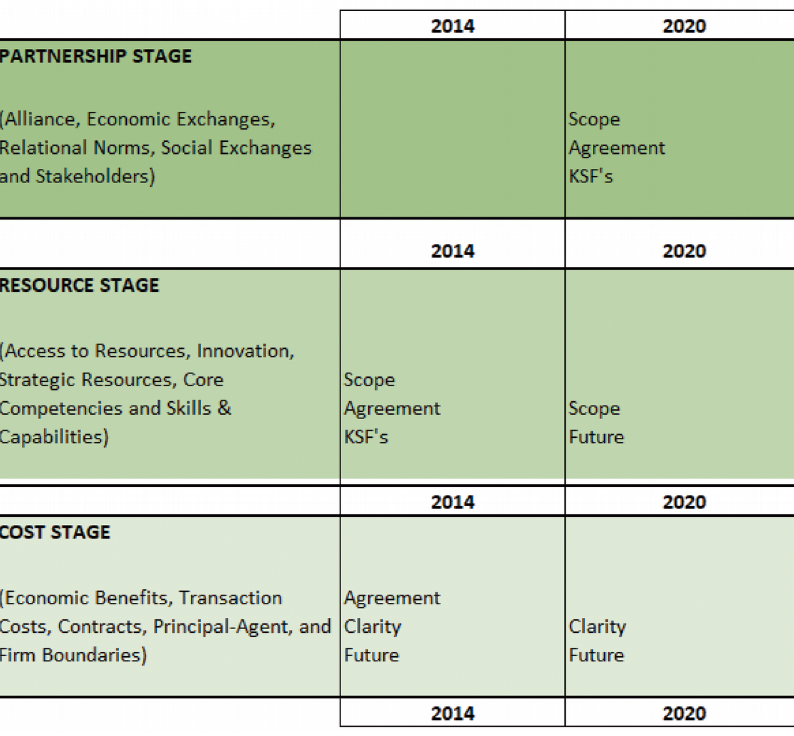
Table 4. Maturity assessments of the interview findings for MRO